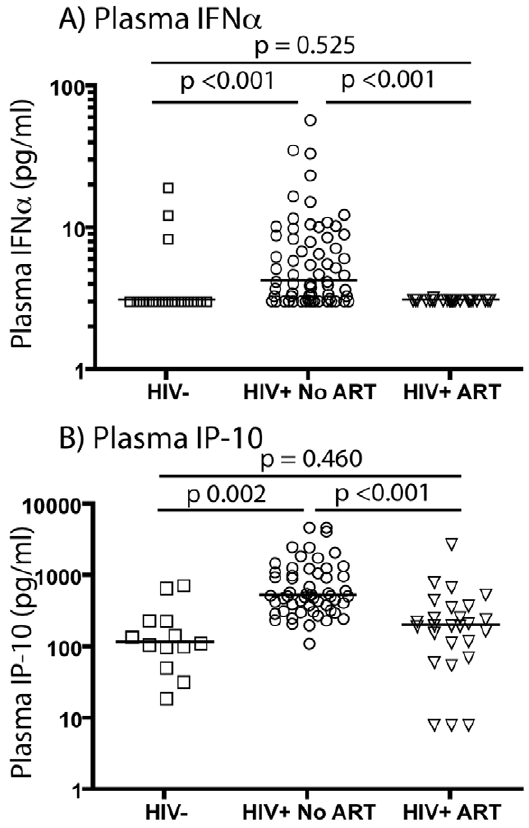
Figure 2. Plasma IFN a and IP-10 levels are comparable between HIV-1 infected subjects on ART and uninfected subjects. IFN a and IP-10 levels were determined in the plasma of 25 individuals with chronic HIV-1 infection who received ART and responded with HIV-1 RNA below assay detection limits ( , 50 copies/ml) for two years or more. IFN a was detected in plasma from only one such donor, and then at trace levels (A). The difference in plasma IFN a level between HIV-1 infected subjects without ART and HIV-1-infected subjects with ART was highly significant (p , 0.001). Plasma IP-10 levels in ART-treated HIV-1- infected donors were comparable to those in uninfected donors (p=0.460) and were significantly lower in comparison to untreated HIV- 1-infected donors (p , 0.001)